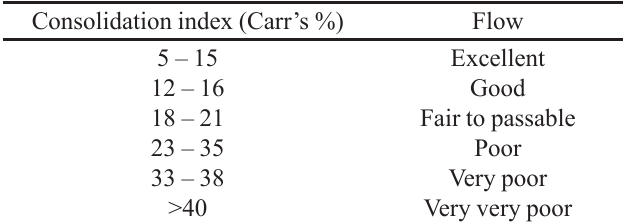
TABLE III - Grading of the powders for their flow